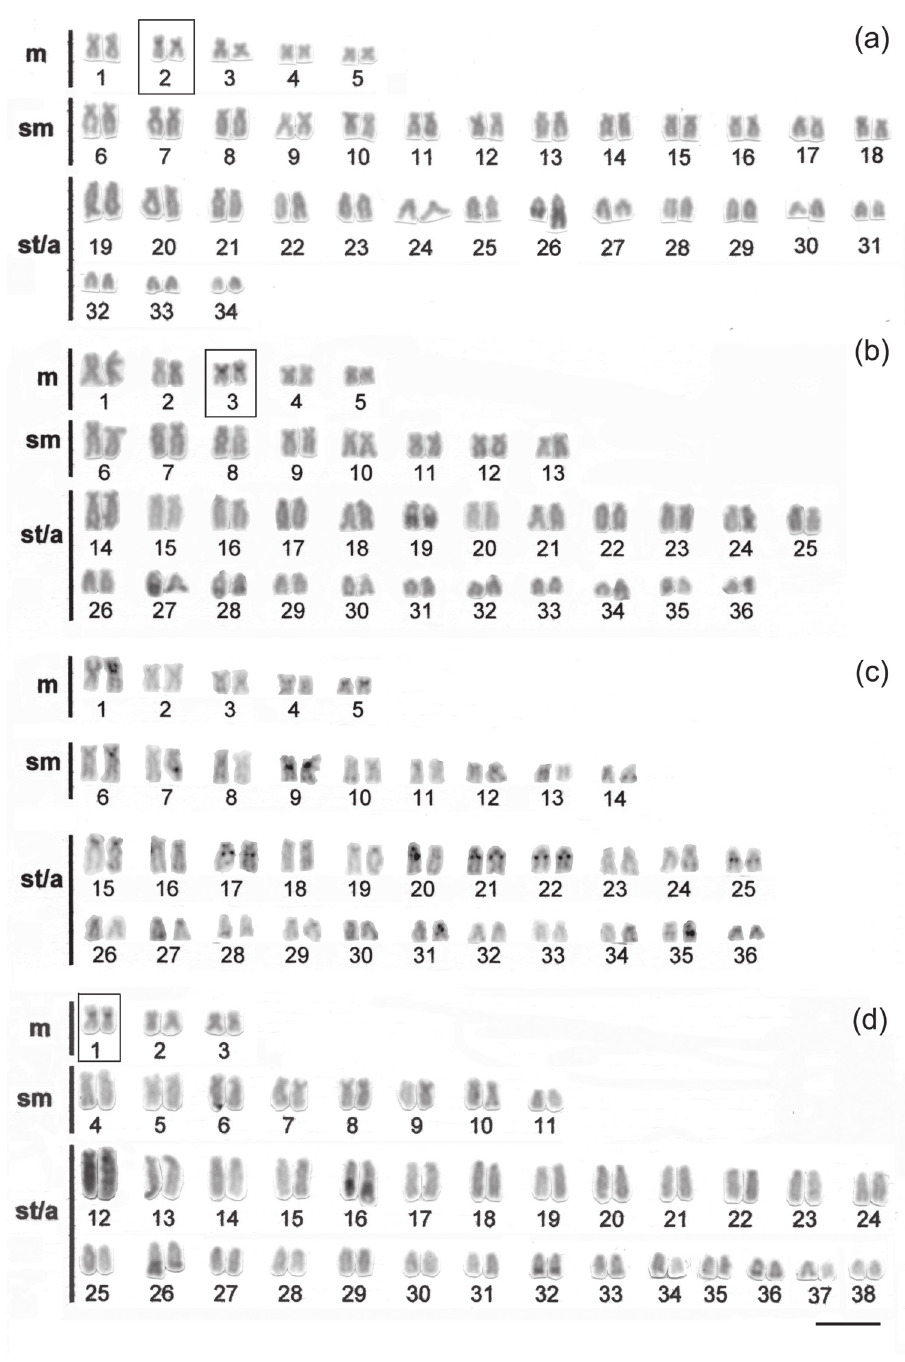
Figure 3. Karyotypes of a H. ancistroides b H. strigaticeps c H. regani and d H. paulinus , arranged from C- banded chromosomes Bar = 10 µ